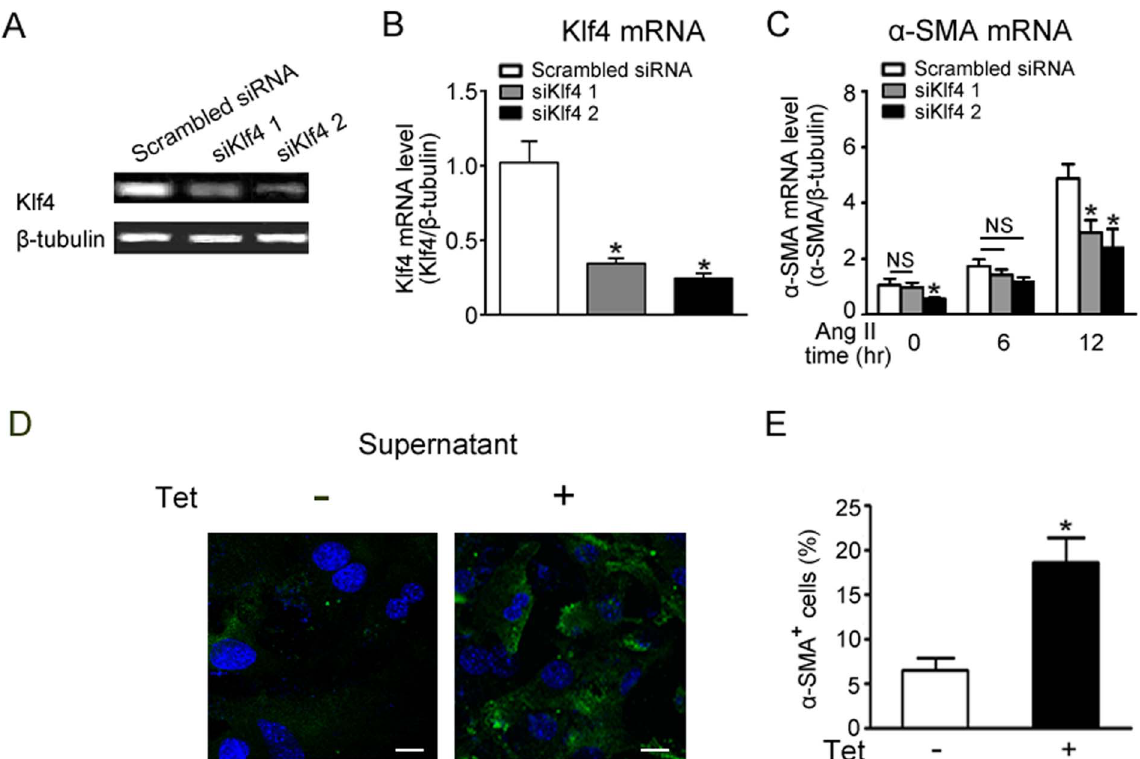
Figure 3. siKlf4 weakens Ang II-induced fibroblast differentiation and collagen synthesis. The effect of Klf4 depends on cytokine secretion. A, semiquantitative PCR of the mRNA levels of Klf4 showed siRNA-mediated knockdown in cardiac fibroblasts. B, Klf4 mRNA levels were assessed by quantitative real-time PCR (qPCR) after siKlf4 transfection (n=3). C, a -SMA mRNA levels were assessed by quantitative real-time PCR (qPCR) after Ang II treatment for 0, 6 or 12 hrs in siRNA transfected cardiac fibroblasts and normalized to b -tubulin (n=3). Data are the mean 6 SEM. *P , 0.05, **P , 0.01 vs. scrambled siRNA. D, cultured cardiac fibroblasts were incubated with supernatants collected from cultured cardiac fibroblasts that overexpressed Klf4 or control. Immunofluorescence analysis was performed after staining with a -SMA antibody. E, quantitative analyses of a - SMA positive cells are presented (n=4). Data are the mean 6 SEM. *P , 0.05 vs. control supernatant.